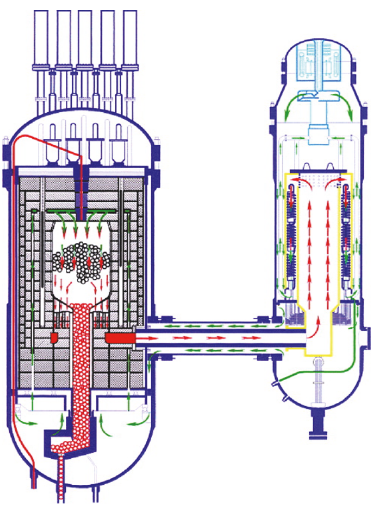
Figure 8: Primary circuit of HTR-10